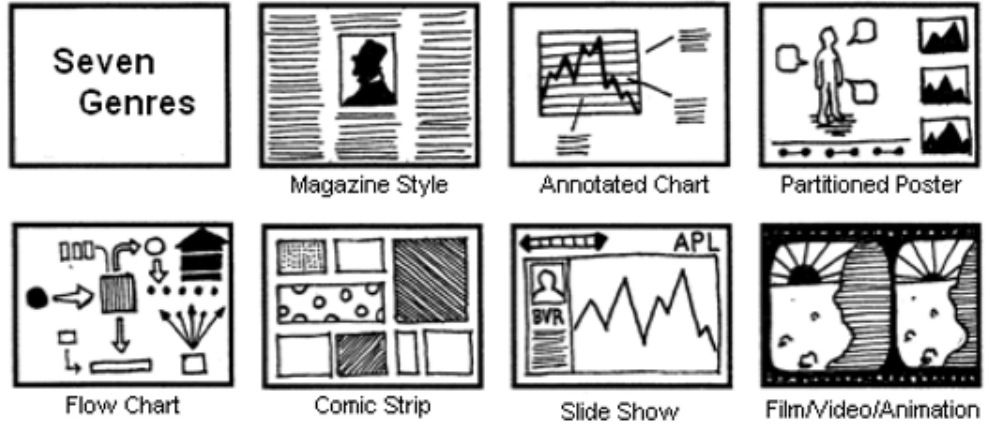
Figure 2: Seven Genres of Narrative Visualizations According to Segel and Heer (2010, p.